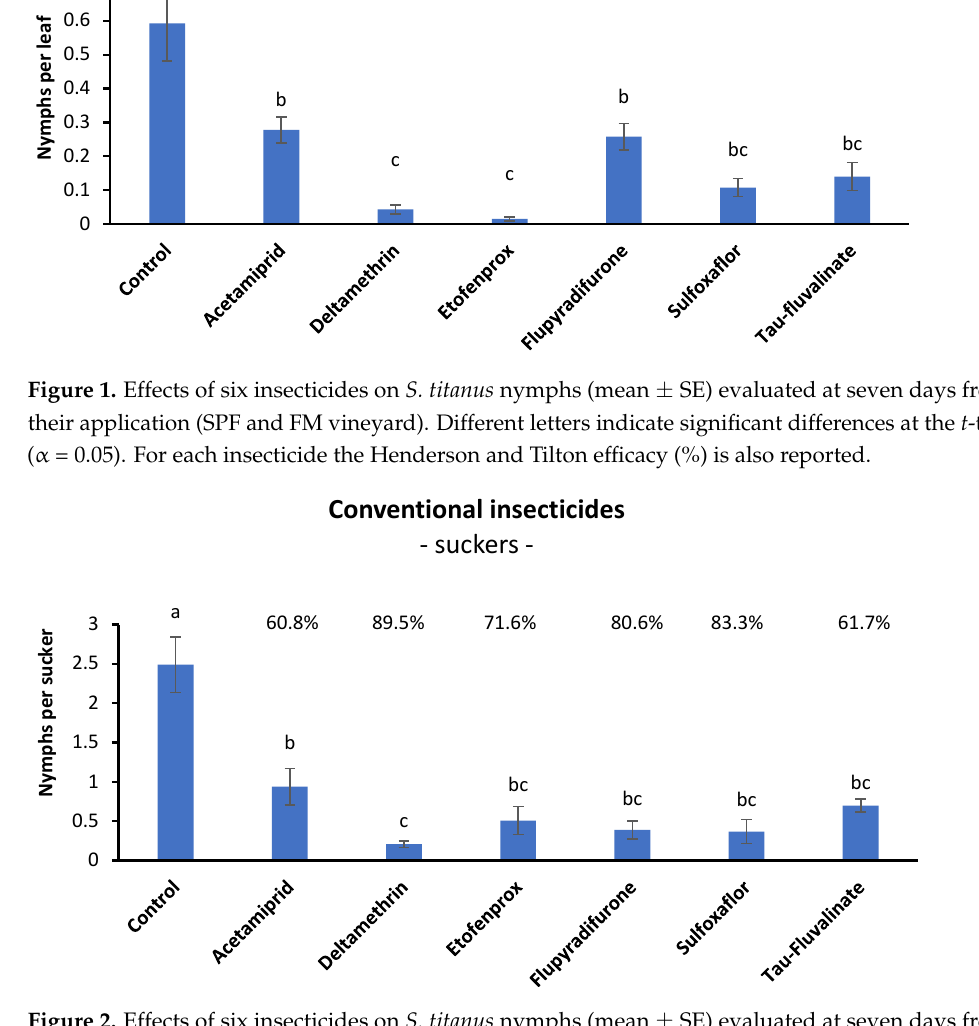
Figure 3. Effects of two applications of five insecticides or kaolin on S. titanus nymphs (mean ± SE) evaluated at 14 days from the first application (SAR vineyard). Different letters indicate significant differences at the t ‐ test ( α = 0.05). For each product the Henderson and Tilton efficacy (%) is also reported.